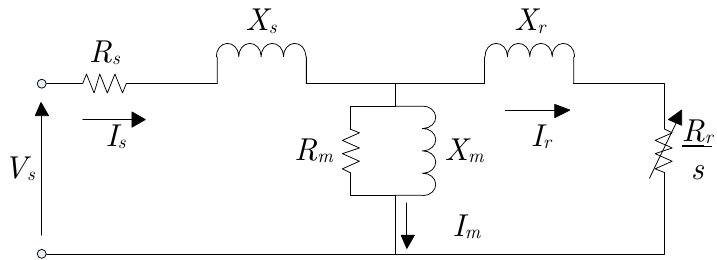
Figure 1. Equivalent electrical circuit for the induction